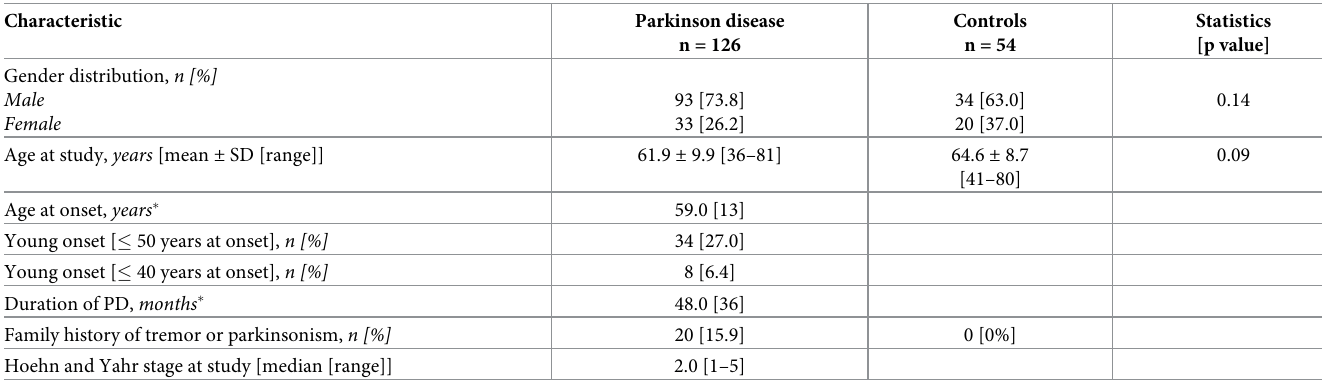
Table 1. Clinical characteristics of Parkinson disease cohort.